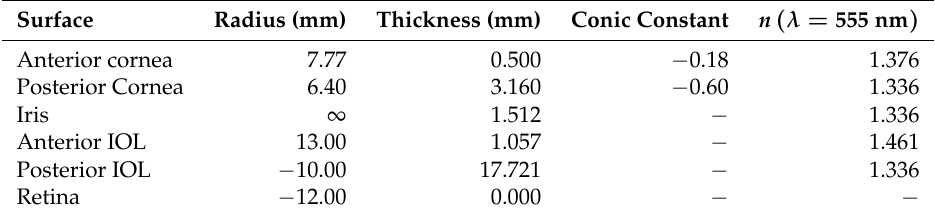
Table 1. Prescription details of the pseudophakic Liou and Brennan model